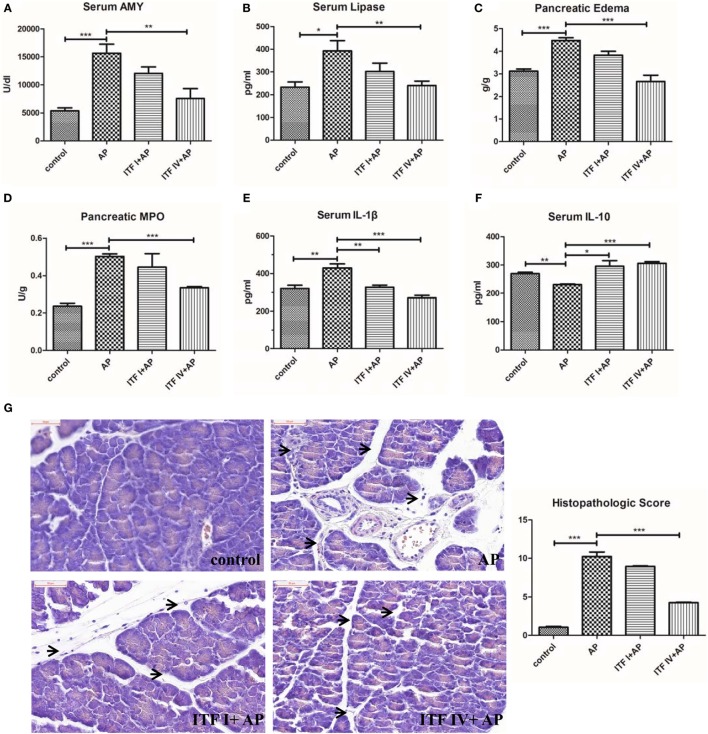
ITF IV attenuating the severity of AP. Mice were fed with 5% ITF I or ITF IV supplemented diets for 72 h before AP induction by caerulein. Serum amylase (A), serum lipase (B), pancreatic edema (C), MPO activity (D), serum IL-1β (E), and IL-10 levels (F) were then determined as described in Section “Materials and Methods,” respectively. Representative photographs showed histomorphology of pancreatic tissues by H&E staining for the indicated groups (bar = 50 µm) and pancreatitis histopathologic score (G). Data shown are means ± SEM. *P < 0.05, **P < 0.01, and ***P < 0.001. AP, acute pancreatitis; H&E, hematoxylin and eosin; IL, interleukin; ITF, inulin-type fructans; MPO, myeloperoxidase.